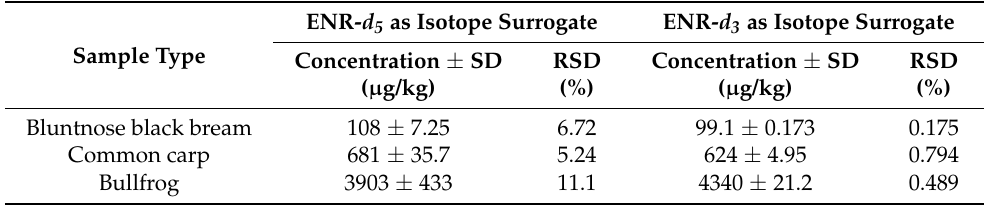
Table 4. Determination of ENR in three aquatic products using ENR- d 5 and ENR- d 3 as the isotope standards (n = 9).